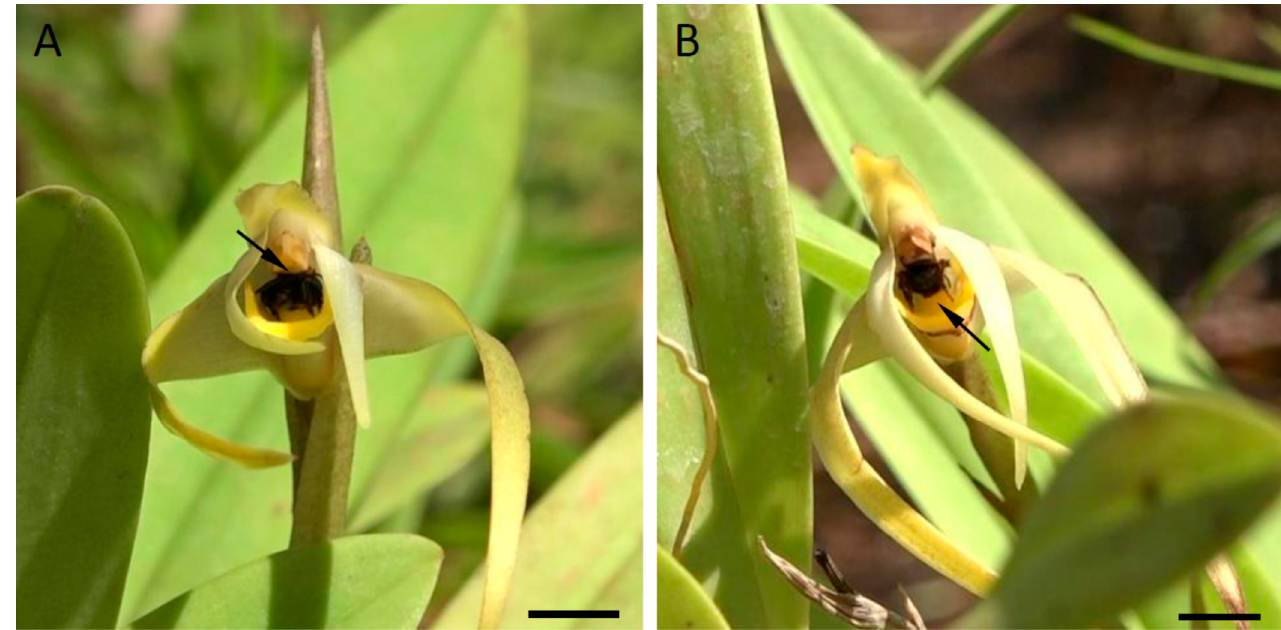
Figure 8. ( A , B ). Field observations. ( A ). The stingless bee Trigona spinipes entering a flower of Maxillaria ochroleuca . Note that the scutellum of the bee is in contact with the viscidium (arrow). ( B ). Trigona spinipes leaving a flower (anther cap and pollinarium removed). Note the callus (arrow) which elevates the body of the bee allowing contact between the dorsal surface of the insect thorax and the reproductive structures of the flower. Scale bars = 1 cm.